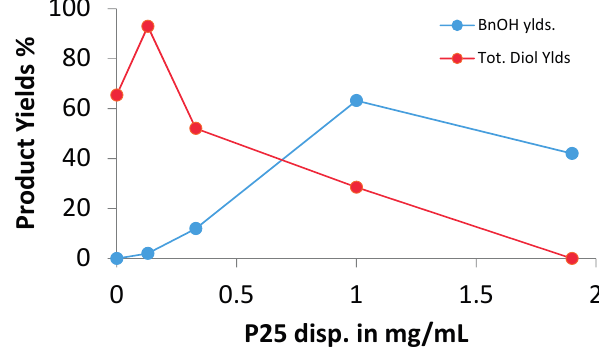
Table 2. Product yields a from SCPC reactions of benzaldehyde with various catalysts. BnOH Diols (9a + 9a') Catalyst (%) D/L: meso